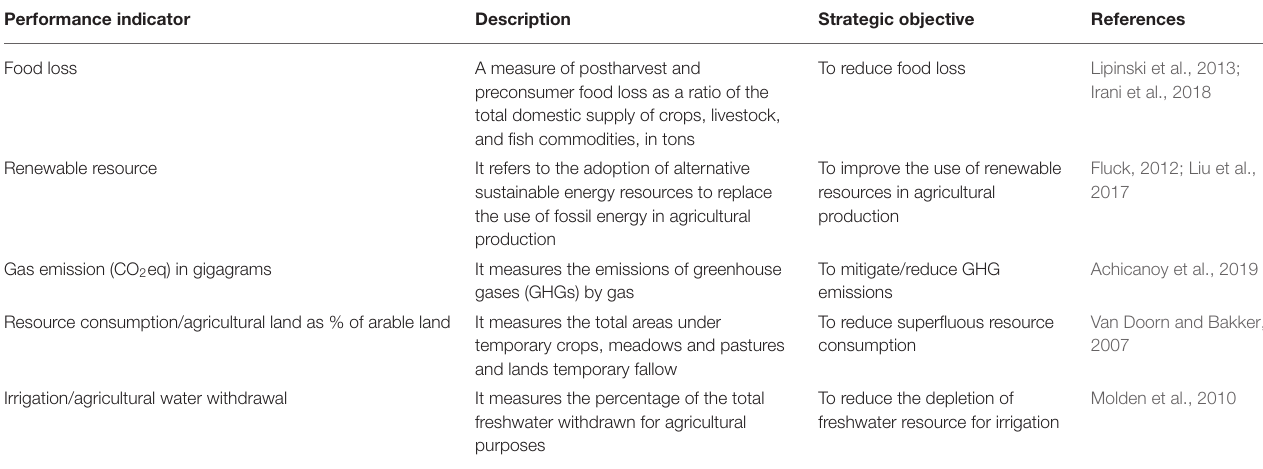
TABLE 5 | Indicators to measure the support to mitigate the environmental damaged caused by the activities of the food